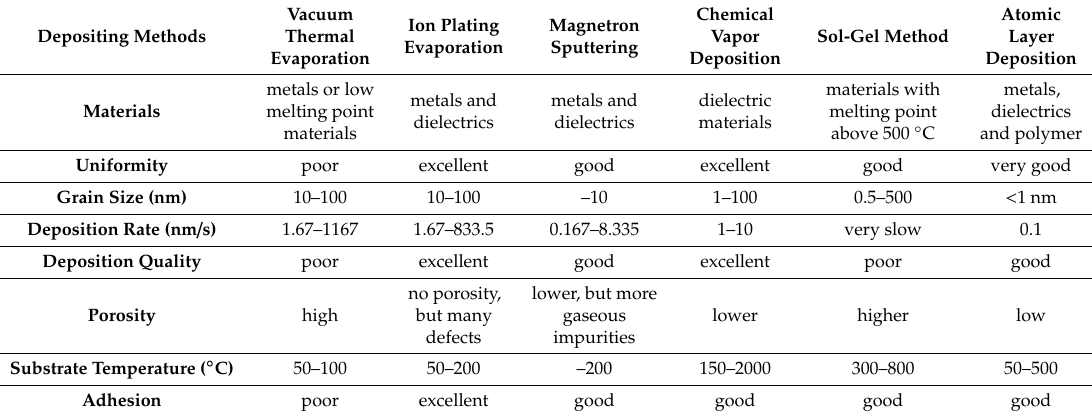
Table 1. Comparison of commonly used deposition methods for producing ZnO:Ga film